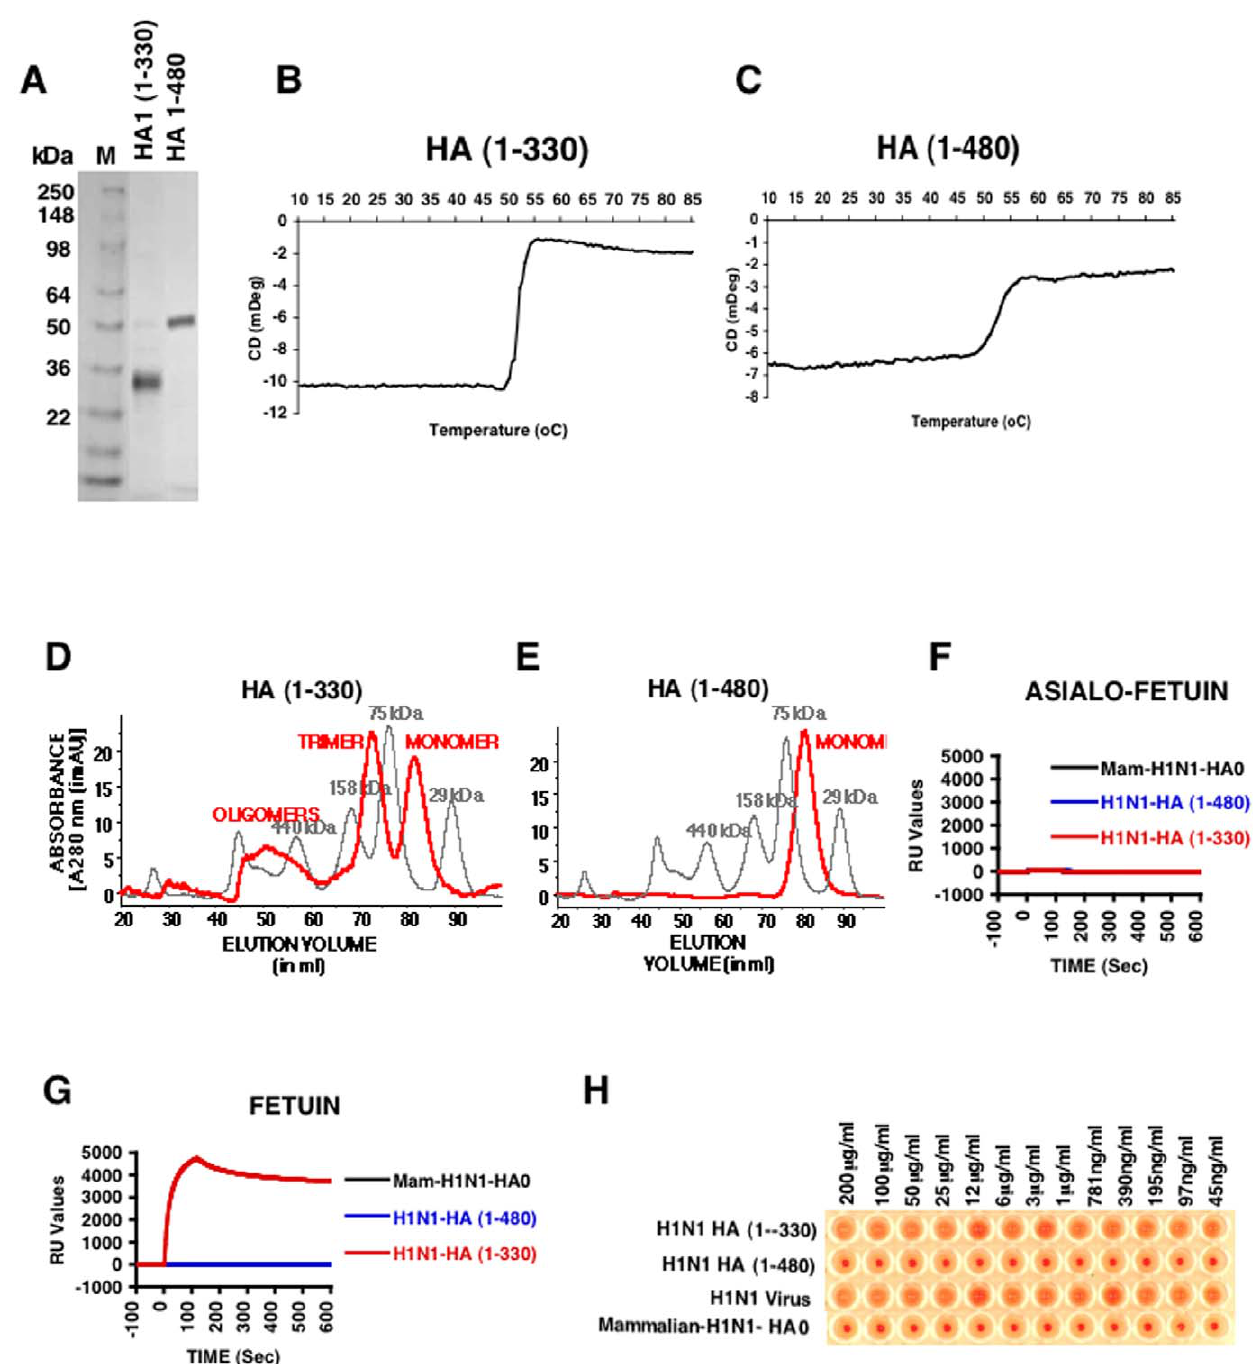
Figure 1. Biochemical and functional characterization of bacterially expressed and purified H1N1 HA proteins. (A) Purified E. coli derived HA proteins were analyzed by SDS-PAGE. DNA encoding HA1 (1–330) and HA (1–480) from HA gene segment of A/California/07/2009 (H1N1) generated from egg-grown virus were used for cloning in a T7 promoter based expression vector (pSK) where the desired polypeptide can be expressed as fusion protein with His 6 tag at the C-terminus. The proteins were expressed, denatured and refolded under controlled redox conditions and purified using His-Trap fast flow chromatography to . 90% purity (see Materials and Methods). The purified proteins run at their corresponding molecular weight in reducing SDS-PAGE. (B-C) CD melt spectroscopy shows that both H1N1 HA1 (1–330) (B) and H1N1 HA (1–480) (C) are properly folded. Both H1N1 HA proteins, at a concentration of 0.5 mg/ml in 20 mM PBS, pH 7.2, were subjected to heating at 0.5 u C/min increments. The protein unfolding kinetics was measured at 222 nm using a J-715 Circular Dichroism system (JASCO corp., Easton, MD). (D-E) Superdex S-200 gel filtration chromatography of purified H1N1 HA proteins from E.coli . The panels present superimposed elution profiles of purified HA proteins (red line) overlaid with calibration standards (grey line). (D) The H1N1 HA (1–330) protein purified from bacterial cells existed as approximately 20% high- molecular-mass oligomer ( . 600 kDa), 45% trimer ( , 110 kDa) and 35% monomer (34kDa) (red line). (E) H1N1 HA (1–480) is present only as a monomer (50kDa). ( F-G ) Binding kinetics of purified H1N1 HA proteins in a SPR based receptor binding assay. Steady-state equilibrium analysis of different H1N1-HA proteins to fetuin and its asialylated counterpart (Asialo-fetuin) was analyzed at 25 u C using a ProteOn surface plasmon